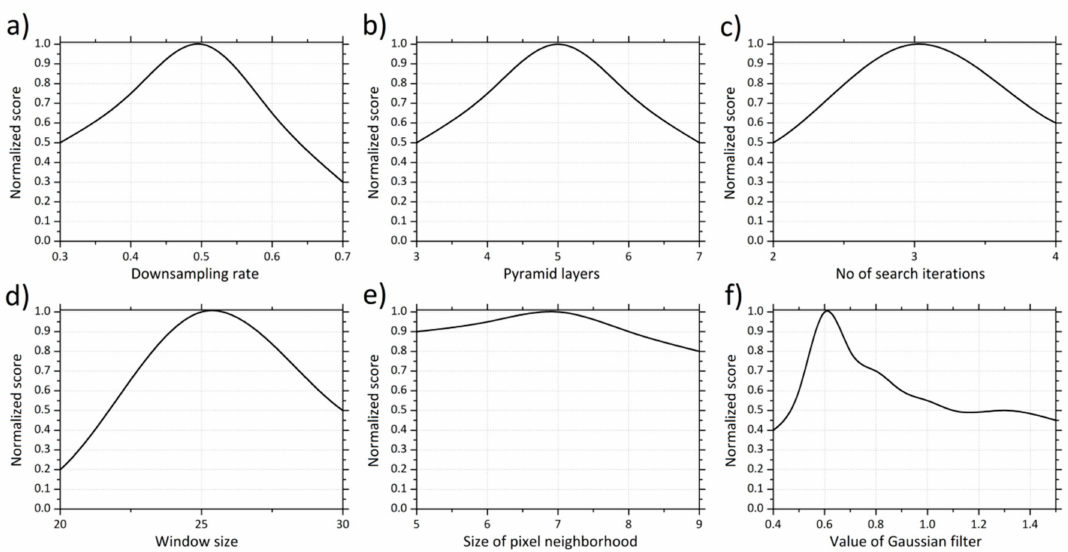
Figure 3. The sensitivity parameters optimization for the CMV COT approach as a function of the normalized score of forecasted pixels for 15 min-ahead time horizon. ( a ) Downsampling rate, ( b ) Pyramid layers, ( c ) Number of search iterations, ( d ) Window size, ( e ) Size of pixel neighborhood, ( f ) Value of Gaussian